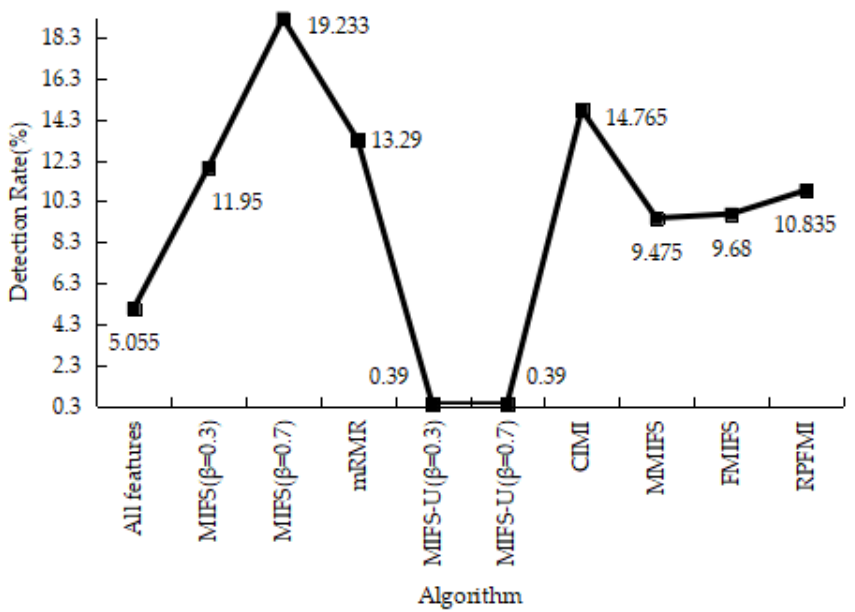
Figure 10. Detection Rate on the R2L test data.